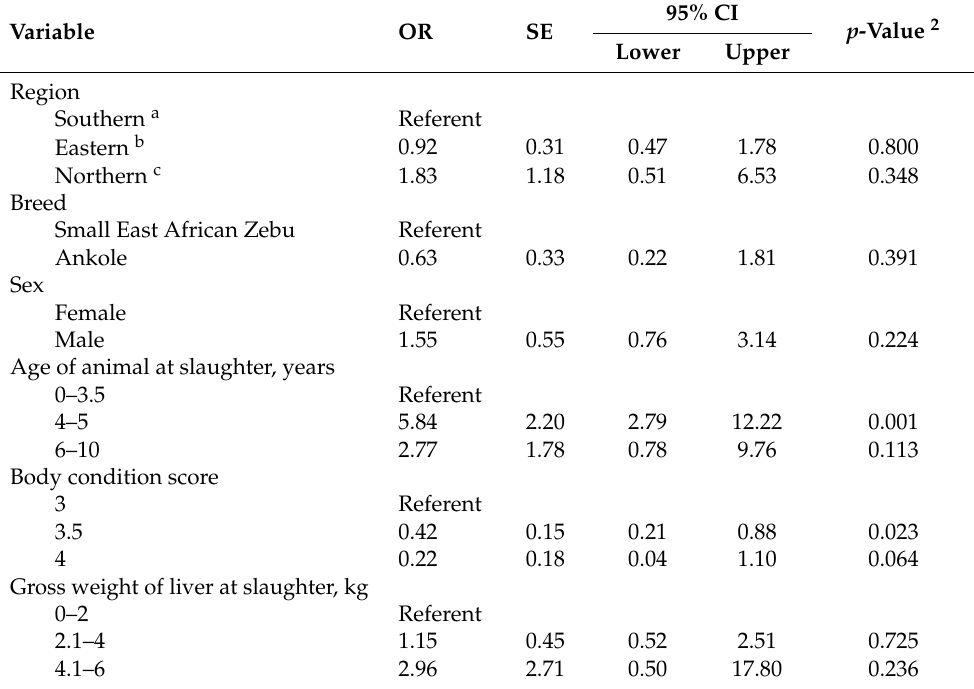
Table 3. Estimated odds ratio (OR) from logistic regression model for the association between fascioliasis infestation (Yes, No) and explanatory variables (region, breed, sex, body condition score, and liver gross